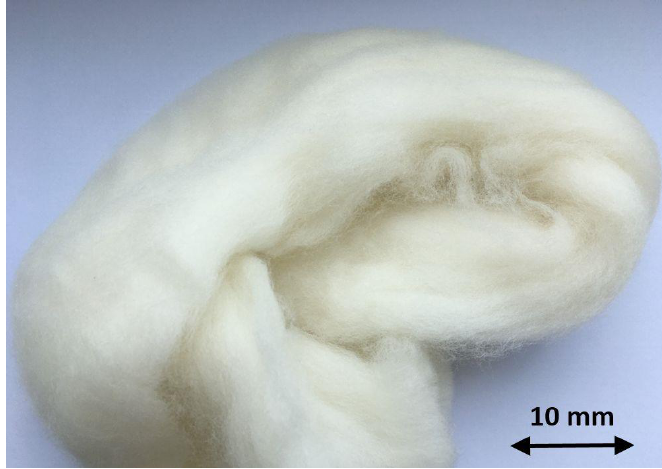
Figure 4. Sheep wool used in cement based composites.